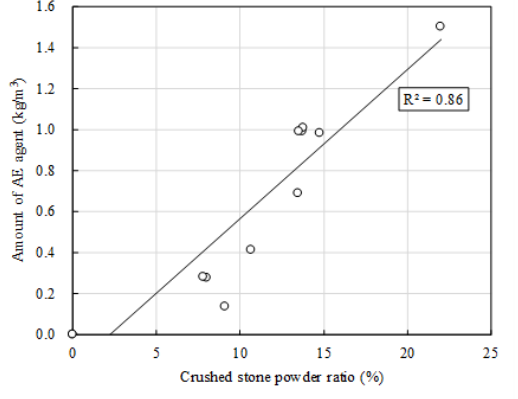
Figure 8. Amount of AE agent.